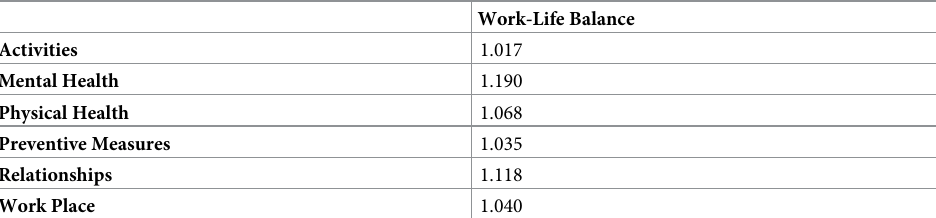
Table 8. VIF values of